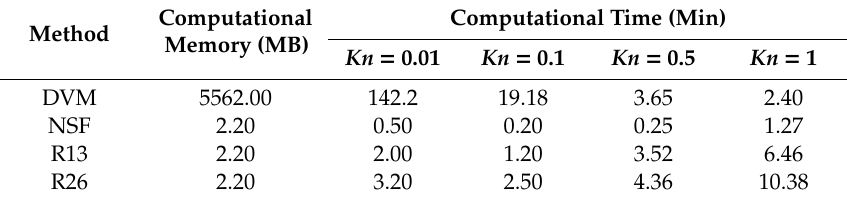
Table 1. Comparison of the computational cost between the DVM and the moment methods.